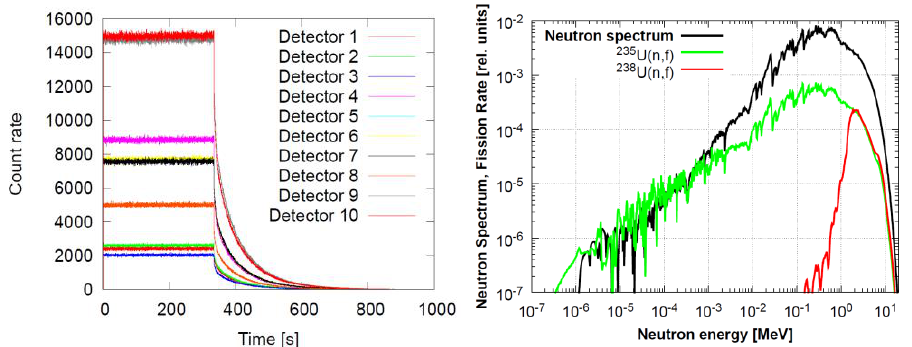
Fig. 3. Left: Detector count rates during a stable critical operation, rod drop and decay. Right: MCNP simulation of neutron spectrum and energy dependence of the fission rates in